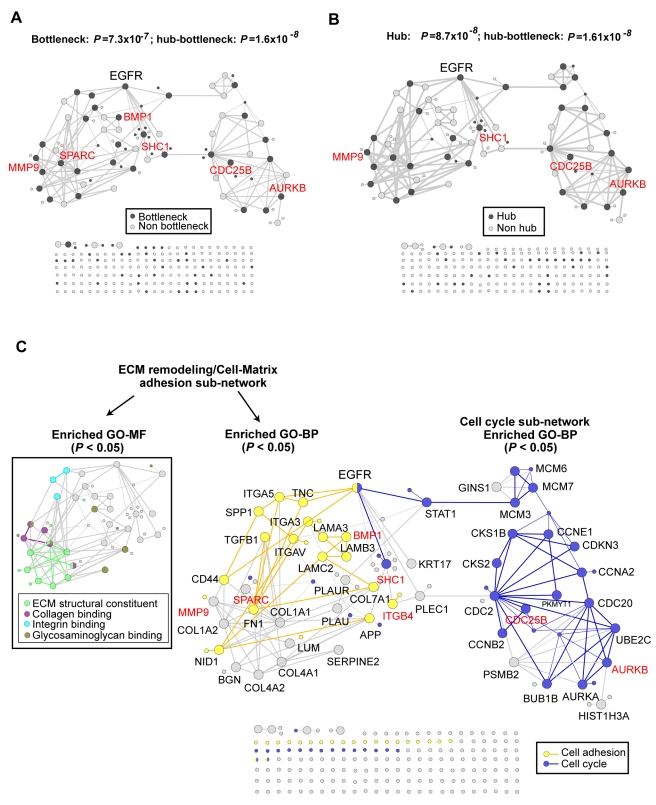
miR-204 gene targets exhibit significant topological properties in a predicted protein interaction network of HNSCC based on single protein network modeling.(A–B) A 56-gene “prioritized HNSCC PPIN” was predicted from single protein network modeling and was significantly enriched with bottleneck (P = 7.3×10−7), hub (P = 8.7×10−8) and hub-bottleneck genes (P = 1.6×10−8). P-values were calculated using one-tailed cumulative hypergeometric tests. Genes colored in red: miR-204 gene targets. (C) Gene Ontology enrichment analysis of the “biological processes” (BP) and “molecular functions” (MF) identified two EGFR-dependent sub-networks in the “prioritized HNSCC PPIN” (adjusted P<0.05). Different BPs and MFs were coded by colors as indicated. Every gene analyzed in the network are represented as circles, the majority do not reach statistical significance and remain as unnamed grey dots on the bottom of the figure (statistical details and names are provided in Table S11, and their interactions in Table S12).